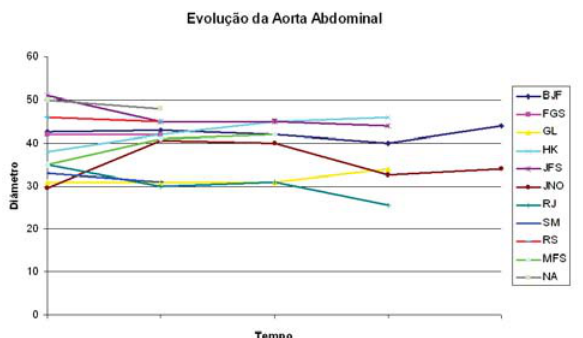
Fig. 2 - Evolução dos maiores diâmetros da porção abdominal da aorta no decorrer do tempo